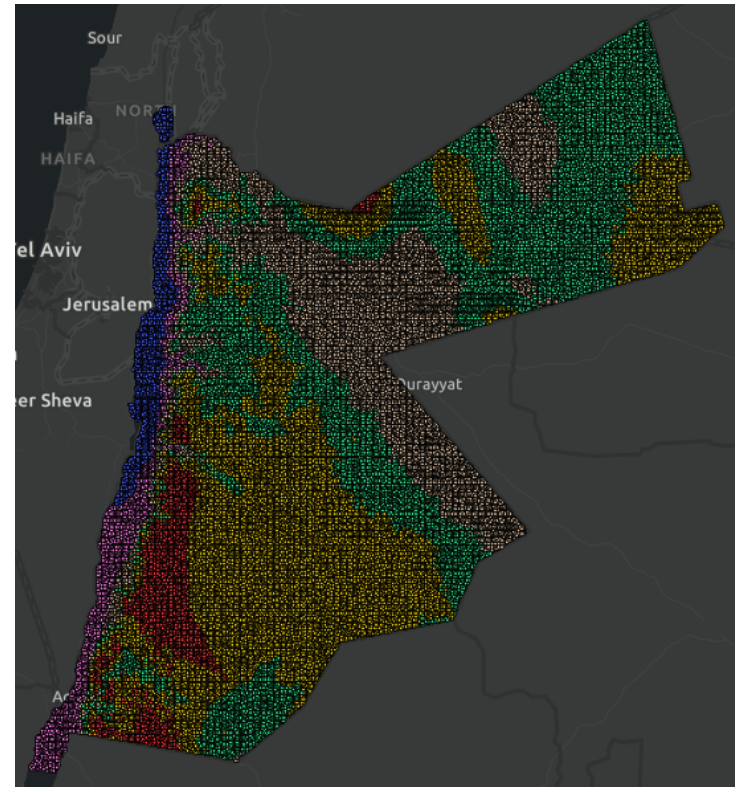
Figure 7. Elevation clustering in Jordan with k =